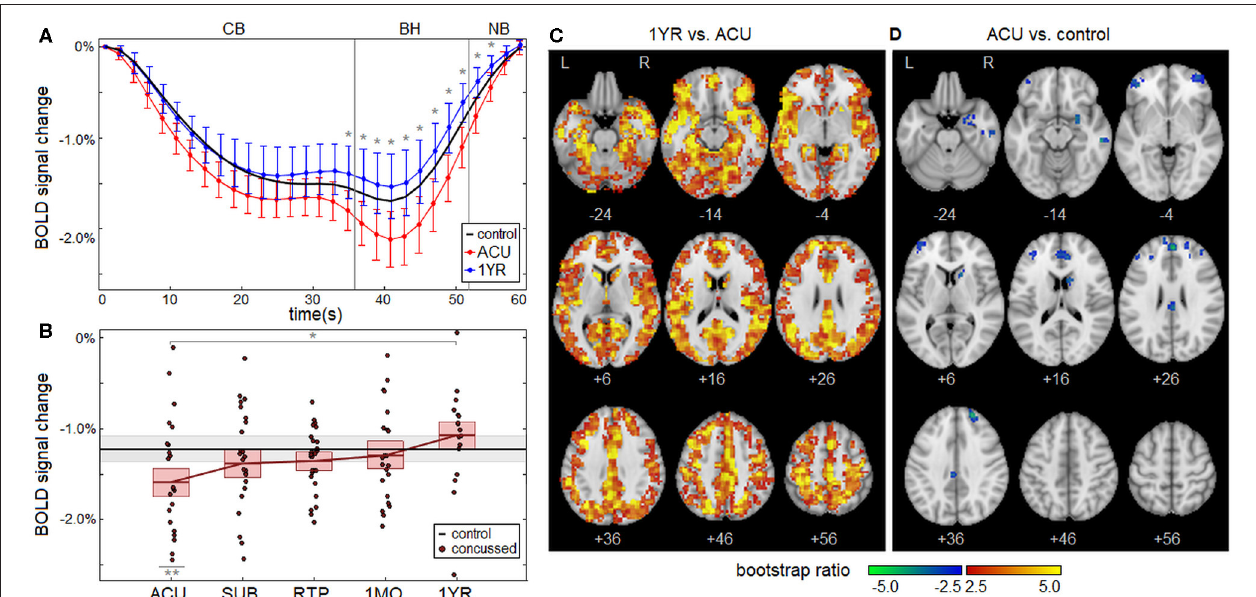
FIGURE 2 | (A) The group average of the mean BOLD temporal response x t , plotted for concussed athletes at acute injury (ACU; red) and 1 year post-RTP (1 YR; blue), along with controls (black). Errorbars denote 95% confidence intervals (95% CIs) of the mean and “*” denotes task time points with a significant effect of imaging session, at an FDR of 0.05. (B) Subject BOLD values, averaged over significant task time points (35–55s), plotted for each imaging session. The horizontal red lines denote group means, and boxes indicate bootstrapped 95% CIs of the means. The mean value for controls is plotted as the thick horizontal black line, with the corresponding 95% CI shaded in gray. In the plots, “*” denotes significant longitudinal change relative to ACU and “**” denotes significant cross-sectional difference relative to controls. (C) Brain regions showing significant differences in BOLD response of concussed athletes at 1 YR relative to ACU. (D) Brain regions showing significant differences in BOLD response of concussed athletes at ACU relative to control athletes.